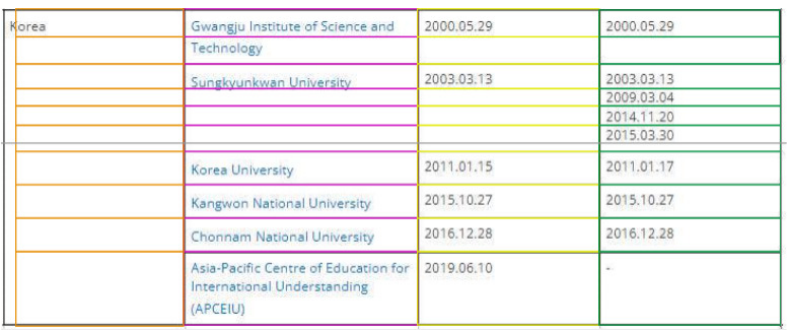
Figure 33. Result with wrong box locations (1).